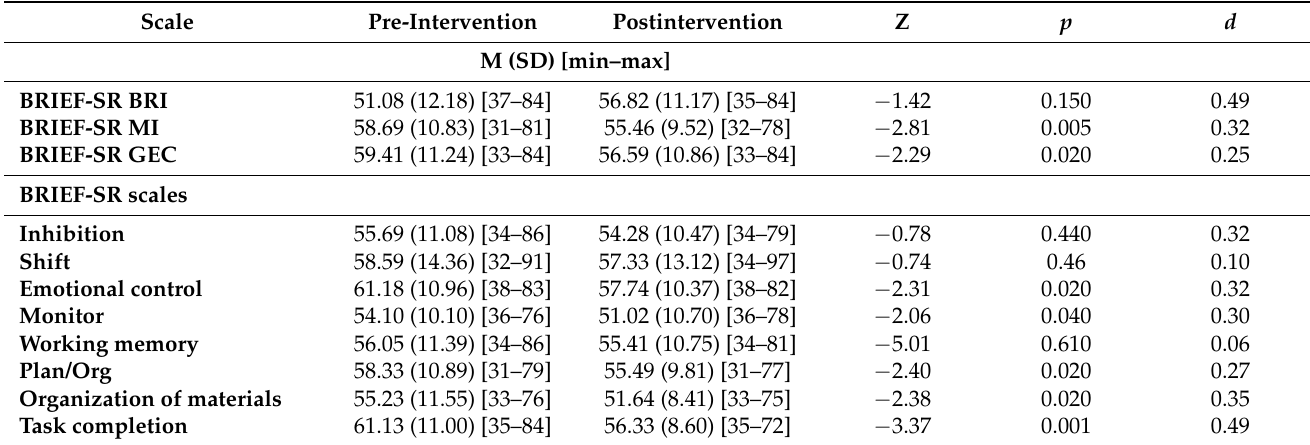
Table 2. Comparison of pre- and postintervention self-awareness of executive functions (awareness of impairment).